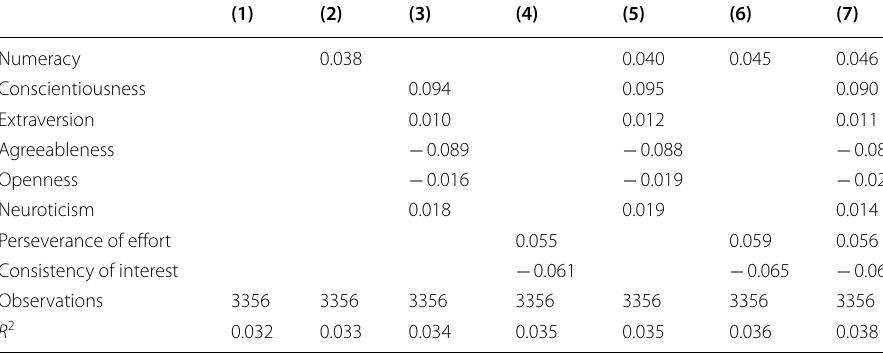
Table 3 Employability and cognitive and non-cognitive